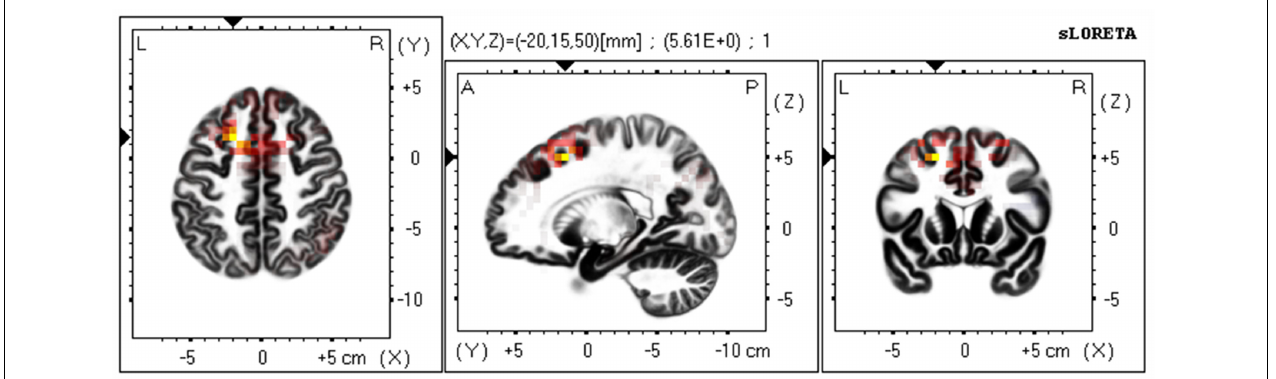
FIGURE 2 | The estimated sources of N170/VPP during a time window of 140–200 ms. sLORETA-based statistical non-parametric maps (SnPM) comparing the standardized current density values between facial expressions with durations of 40 and 300 ms ( n = 12) at the N170/VPP latency (140–200 ms). Significantly increased activation ( p < 0.05) at the 40 ms duration compared to the 300 ms duration is shown in red. Each map consists of axial, sagittal, and coronal planes. The maxima are color coded as yellow. L, left; R, right; A, anterior; P, posterior.